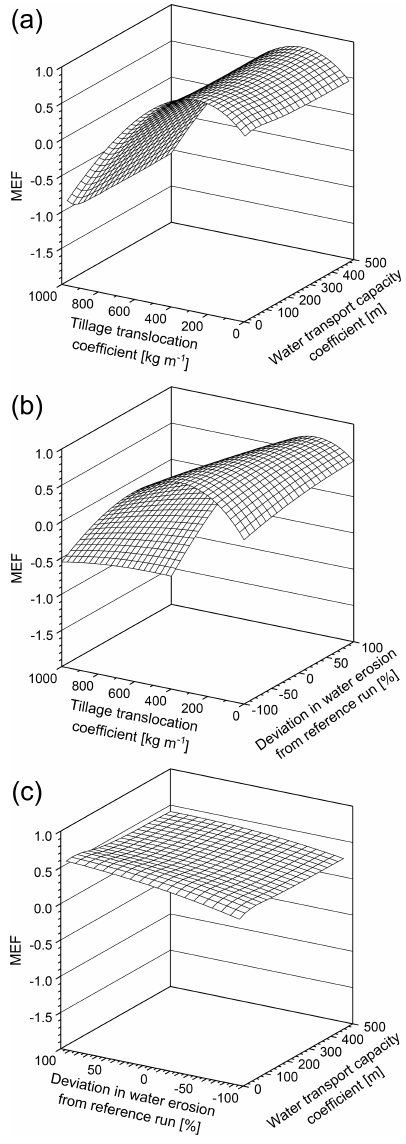
Figure 6. Inverse modelling of tillage and water erosion compared to 239 + 240 Pu-derived soil redistribution. Three parameter combi- nations (tillage transport coefficient, k til ; water transport capacity coefficient, k tc ; deviation in water erosion strength compared to ref- erence parameterisation) are tested on their effect on the goodness- of-fit, represented by the MEF (model efficiency coefficient: perfect model fit = 1; model prediction as good as the mean = 0; model pre- diction worse than mean = < 0).